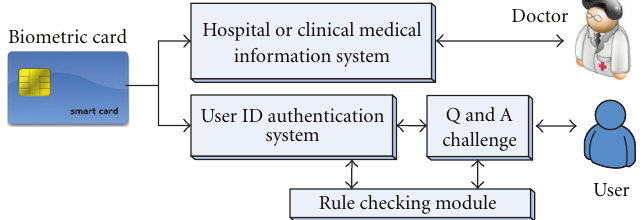
Figure 2: Workflow of the two uses of the h-data from the biometric card.